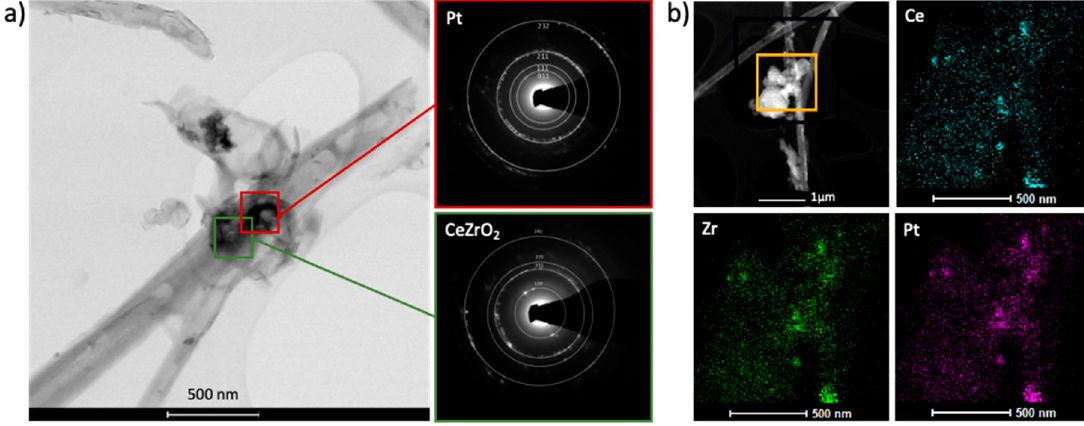
Catalysts 2021 , 11 , 563 Figure 4. Bright field TEM with SAED ( a ) and elemental mapping for C, Ce, Zr and Pt (b) for Pt-CZ/CFF.